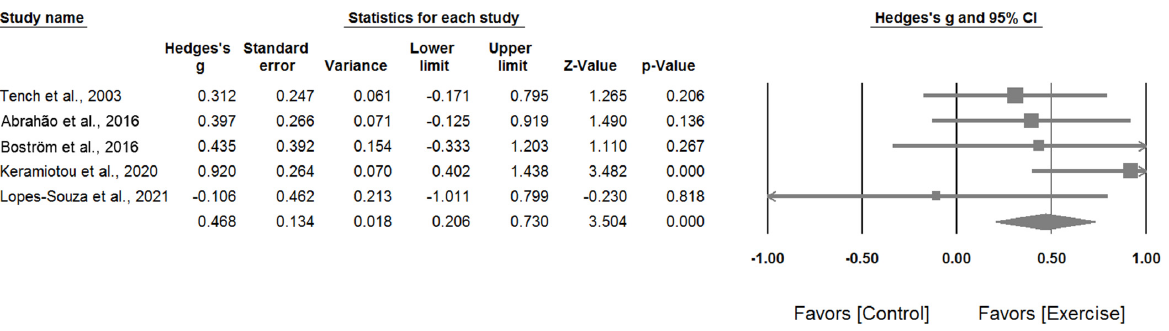
Figure 3. Forest plot of comparison with the outcome of the physical health and function aspect of health-related quality of life.